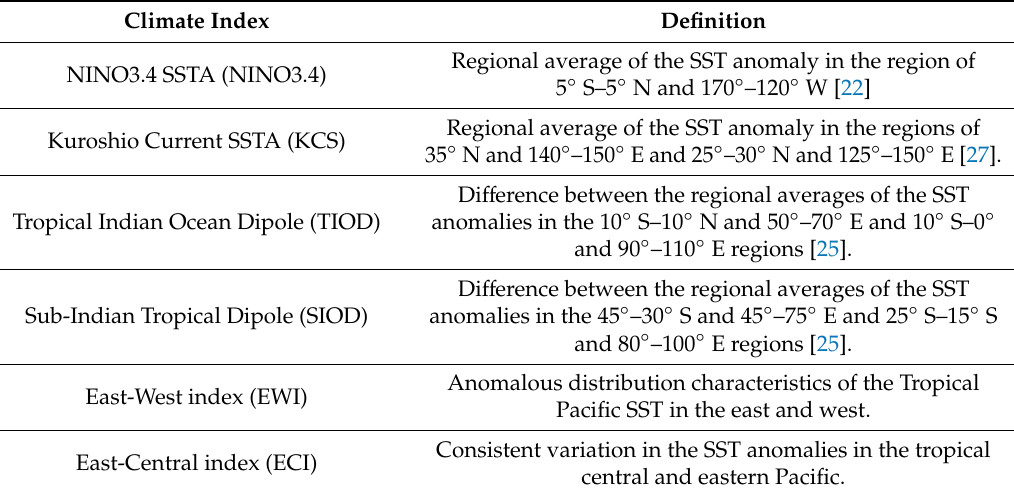
Table 2. Definition of SST indices.